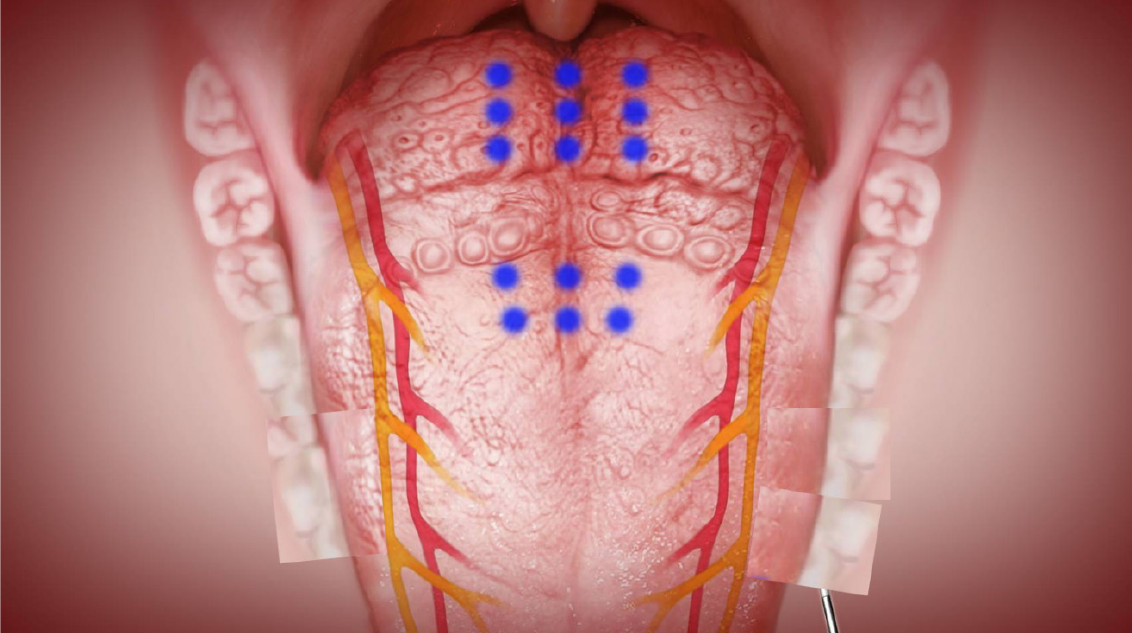
Figure 4. Procedures of the coblation ablation tongue (CAT) included 6-point ablation of the tongue body and 9-point ablation of the tongue base.